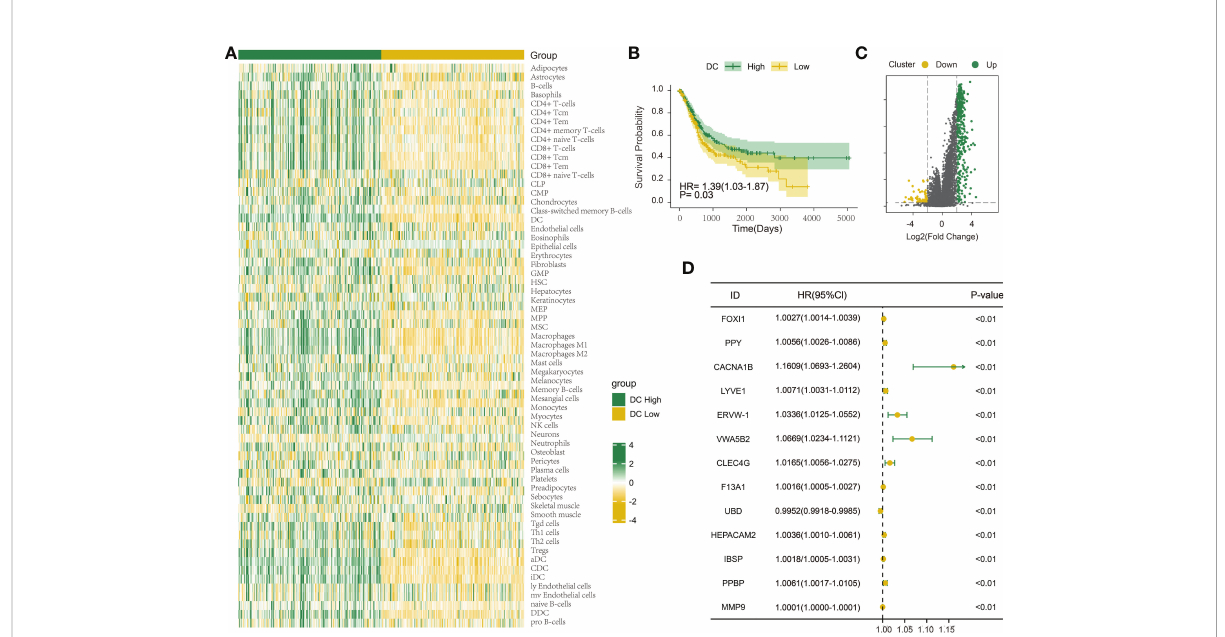
FIGURE 1 Investigation of the DC in fi ltration-associated expression change in bladder urothelial carcinoma (BLCA). (A) Heatmap showing the degree of in fi ltration of 64 immune cell types in the TCGA-BLCA cohort (n = 404) using xCell based on a set of 10,808 genes. (B) Survival analysis indicated that patients assigned to the two clusters [DC High (n = 202) and DC Low (n = 202)] had signi fi cantly different survival outcomes in the TCGA-BLCA cohort. (C) Volcano map shows 396 differentially expressed genes between DC High and DC Low. Green dots indicate upregulation and yellow dots indicate downregulation. (D) Univariate Cox regression analysis was used to screen genes associated with clinical prognosis with a p-value< 0.01 in the TCGA-BLCA cohort.